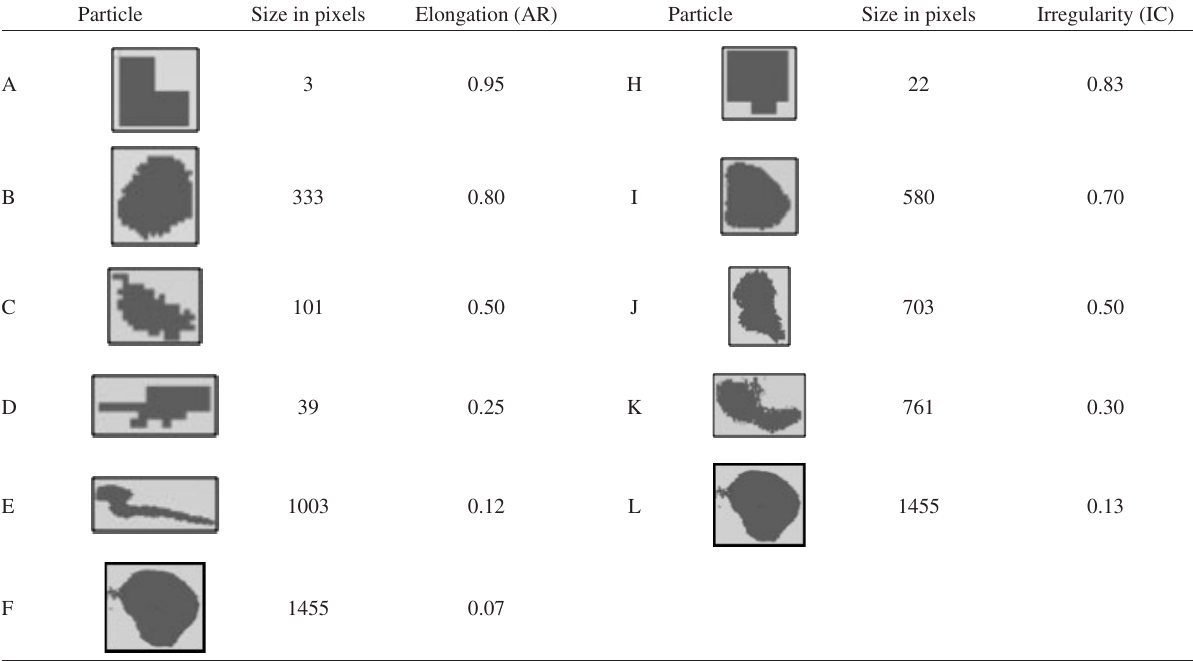
Table 4. – Selection of particle images information: number of pixels, elongation (AR) and irregularity (IC) indexes. High elongation and irregularity of the particles correspond to lower index values. Note that the high particle size (in pixels, F and L) interferes with a good inter- pretation of both morphometric indices (AR and IC).